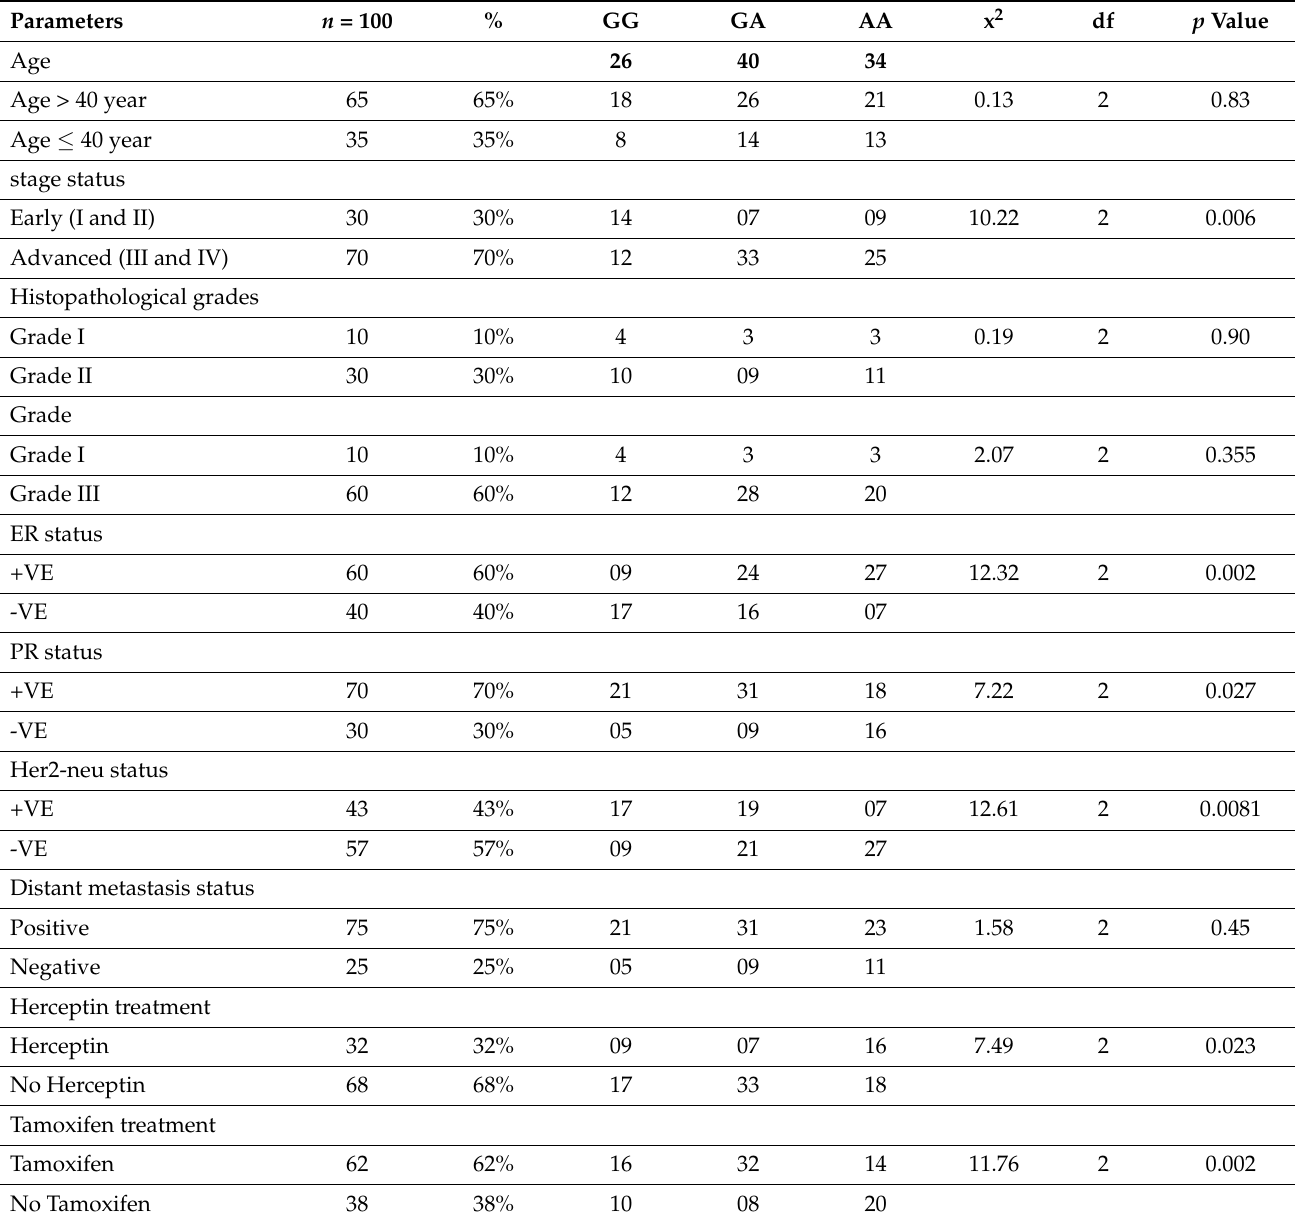
Table 10. Association of clinicopathological characteristics of BC patients and the genotype of KLF-14 (rs972283 A >